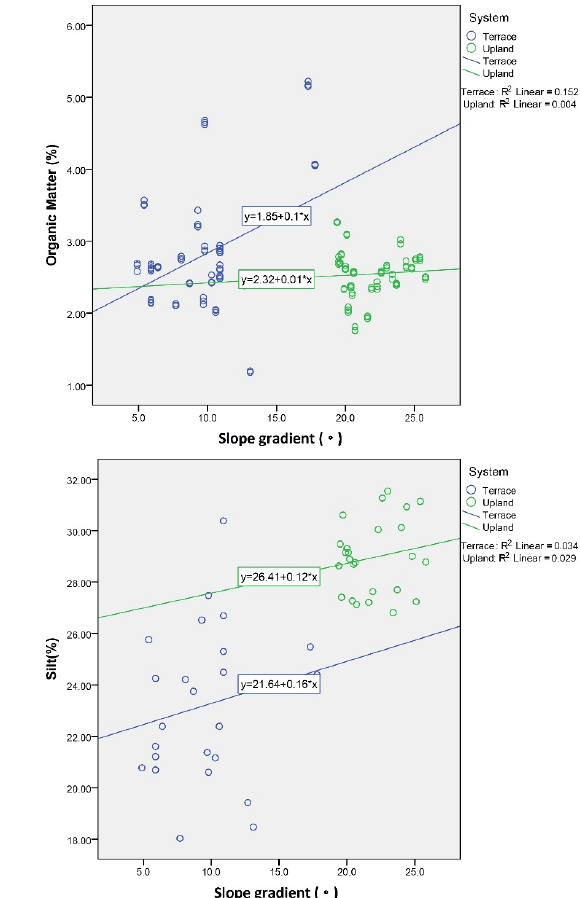
Figure 3. Comparison of soil physical and chemical properties between terraced paddy field and upland rice.